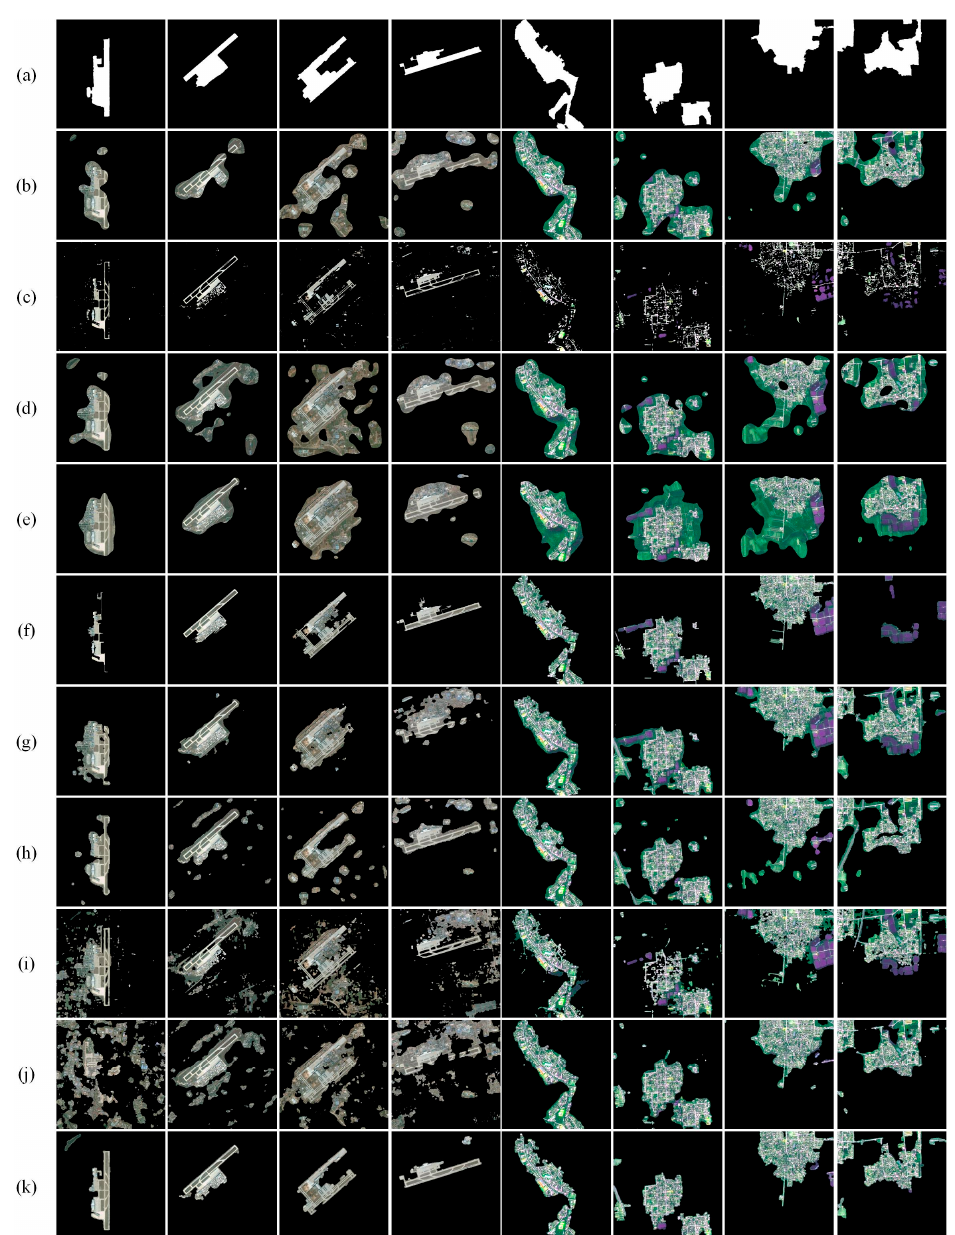
Figure 8. Comparison of ROIs for noise-free images (first four images are from the SPOT5 satellite and last four are from Google Earth): ( a ) ground truth; ( b ) SR; ( c ) FT; ( d ) ITTI; ( e ) GBVS; ( f ) H; ( g ) CA; ( h ) FDA; ( i ) WT; ( j ) MFF; and ( k ) LI.